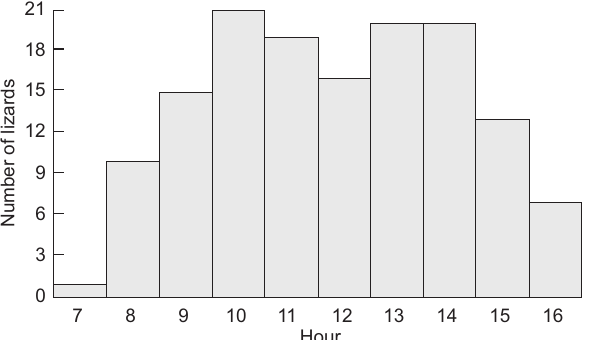
Figure 2. Activity period of C. ocellifer at the Morro do